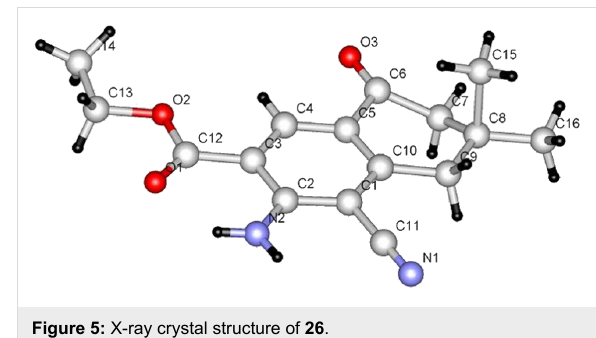
Figure 5: X-ray crystal structure of 26